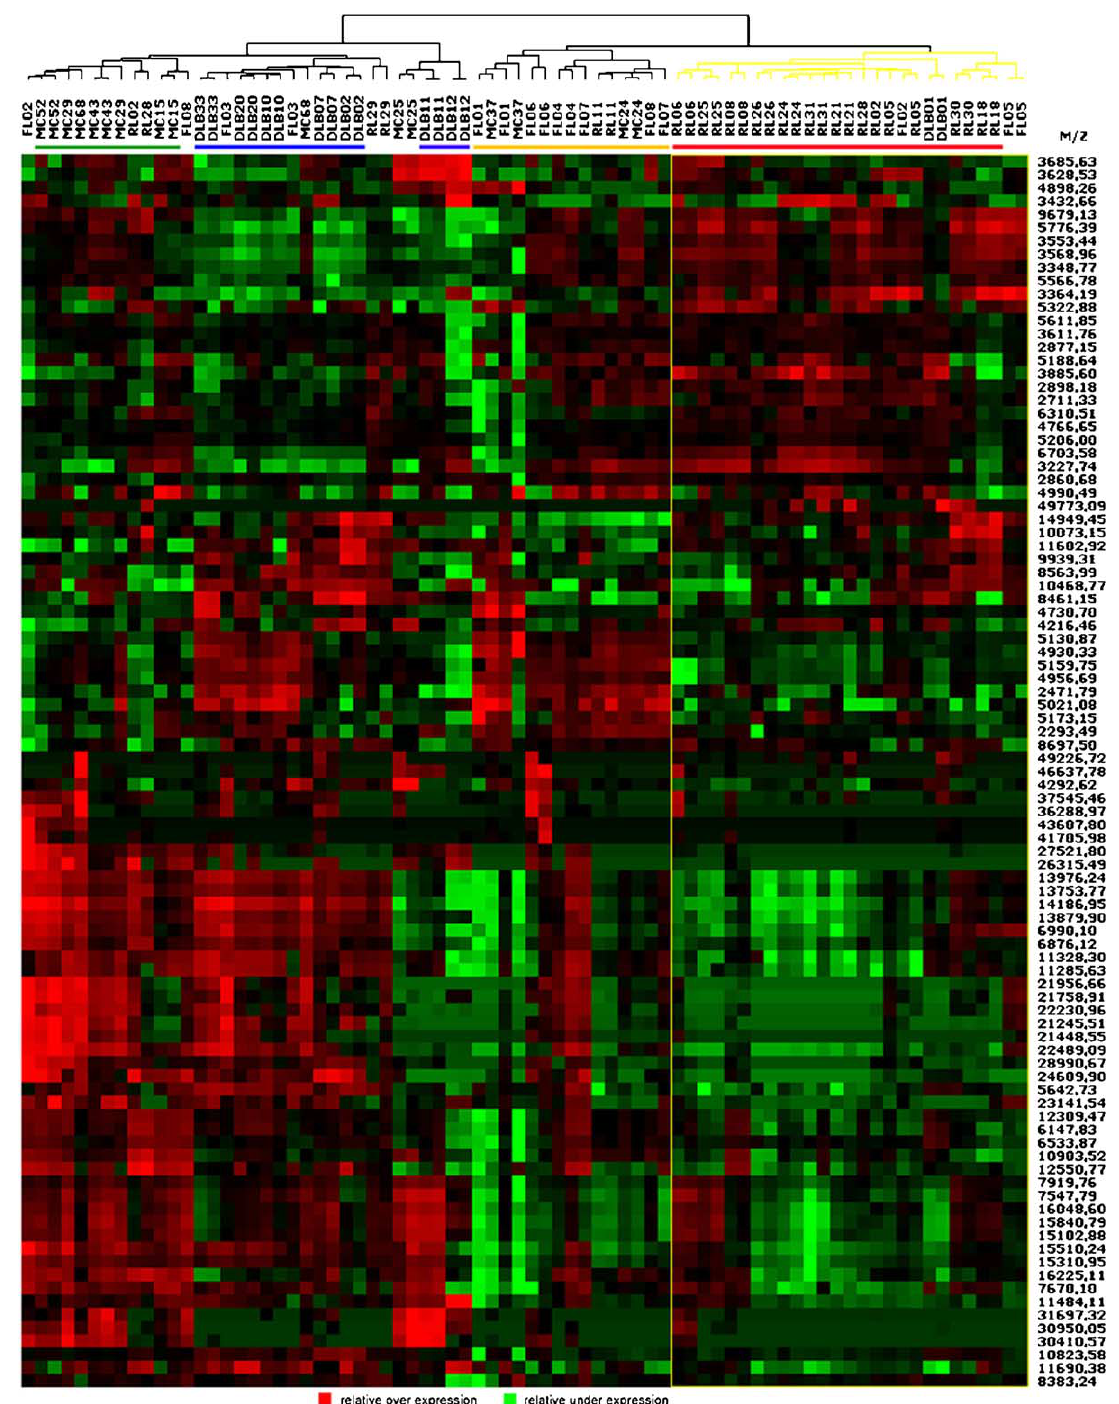
Fig. 5. Unsupervised clustering of SELDI-TOF MS data of reactive lymph nodes, DLBCL, FL and MCL. Along the X -axis are the lymphoma cases (each case in duplicate) (MC = MCL; DLB = DLBCL; RL = benign lymph node) and along the Y -axis are the M/Z values of the peaks that were generated in these spectra and these peaks are all used in this unsupervised clustering. On the right, a cluster of benign, reactive lymph nodes (red bar) and FL cases (yellow bar) is formed, and on the left DLBCL (blue bar) and MCL (green bar) cases cluster